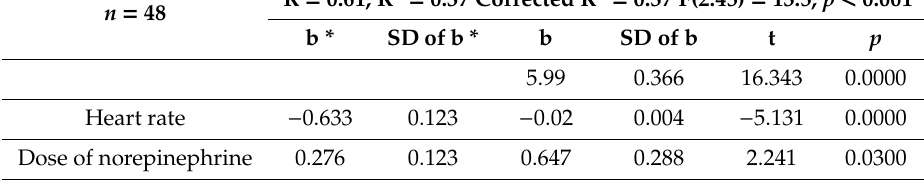
Table 1. A multiple regression analysis describing the dependence between the index of cardiac-electrophysiological balance (iCEB) and parameters selected on Pearson’s correlations in whole studied population.